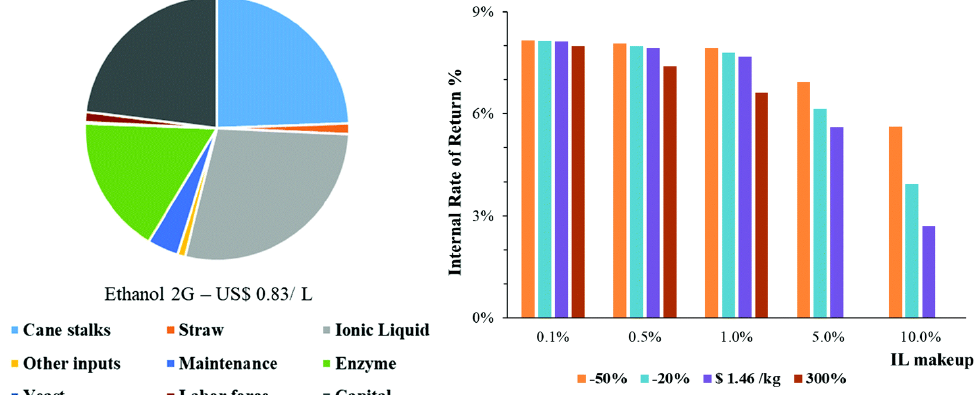
Figure 12. Breakdown of anhydrous ethanol production cost, considering the pretreatment scenario at 130 °C with water content in liquid fraction of 30% w / w , solid content of 30% w / w , and IL make-up of 5%. The production cost of 1 L of ethanol is USD 0.83. The total yearly production cost for ethanol is USD 88.4 million ( left ). Impact of IL make-up and price on the economic feasibility of the process in terms of the internal rate of return ( right ) (reprinted with permission from [124]. Copyright © 2021, Royal Society of Chemistry).